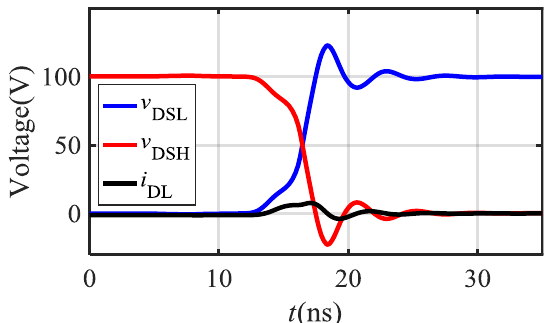
Figure 6. Effect of parasitic inductance on the drain current i DL and gate-source and drain-source voltage waveforms.